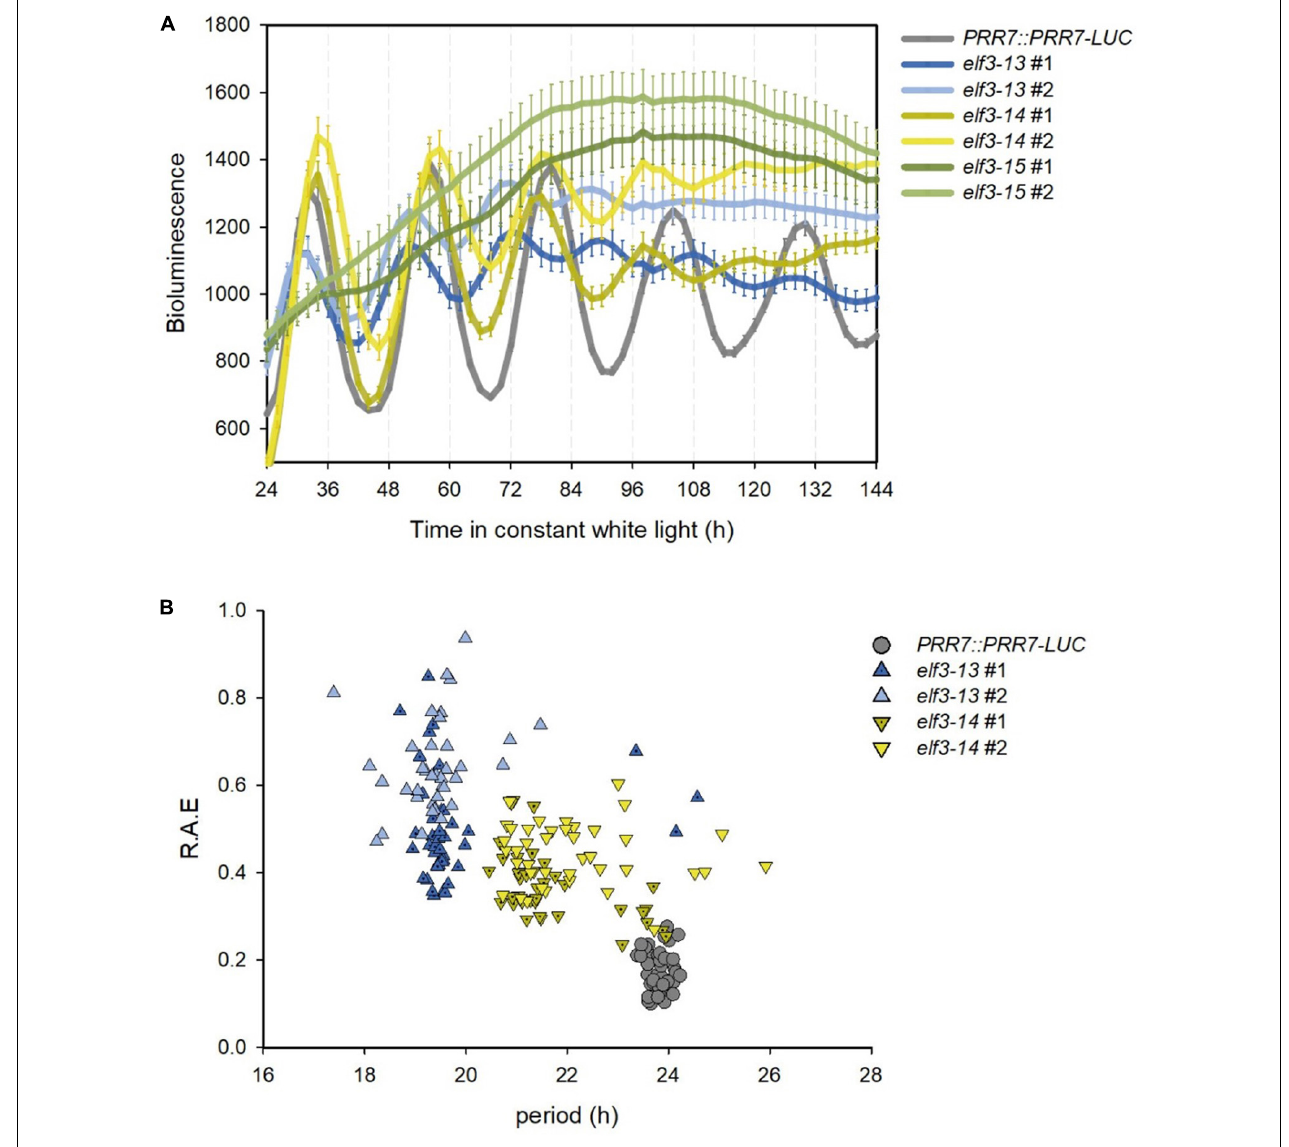
FIGURE 4 | Effects of novel elf3 mutations on circadian period. 7-day old seedlings of PRR7::PRR7-LUC , elf3-13 , elf3-14 , and elf3-15 were entrained in 12L:12D white-light cycles, then moved to continuous white light (50 µ mol m − 2 s − 1 ) and luminescence images obtained from ZT2 every 2 h for 7 days. (A) Free-running bioluminescence profile of PRR7::PRR7-LUC activity. Mean of luminescence values shown with error bars corresponding to SEM ( n > 37). (B) Period versus relative amplitude error